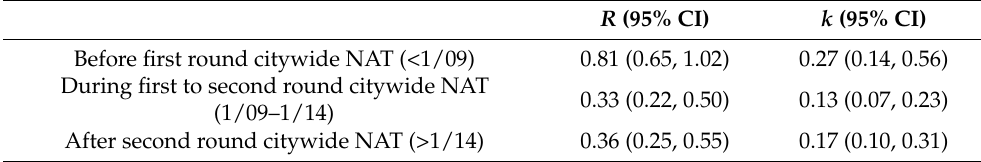
Table 2. Impact of non-pharmaceutical interventions on SARS-CoV-2 transmission dynamics. R (95% CI) k (95% CI) Before first round citywide NAT